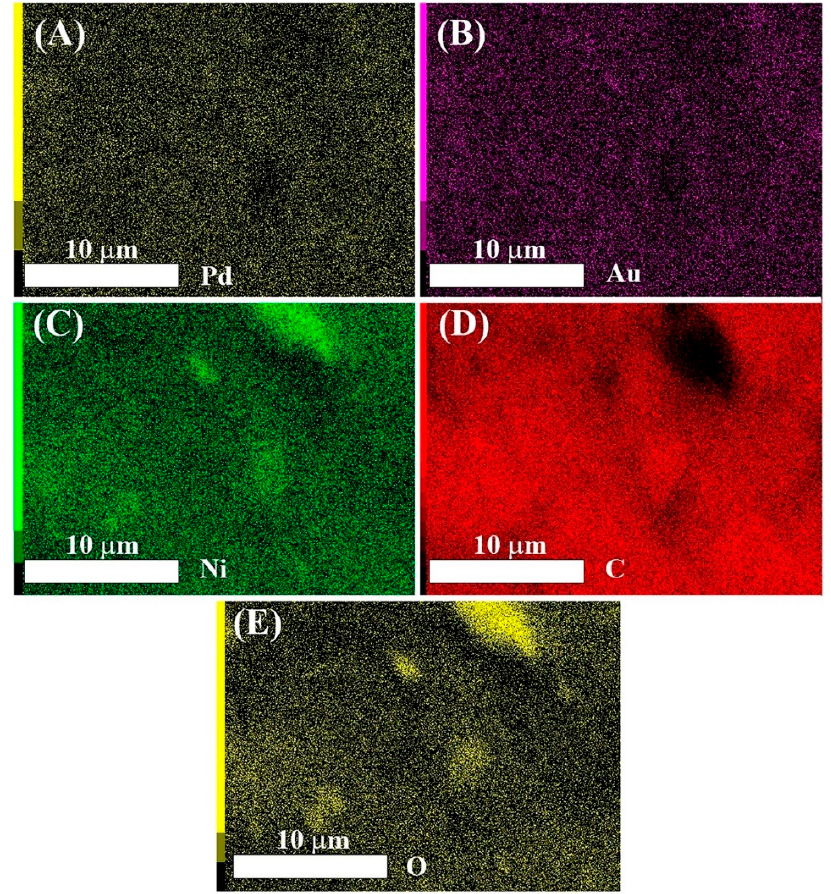
Figure 2. Elemental maps of ( A ) Pd, ( B ) Au, ( C ) Ni, ( D ) C, and ( E ) O obtained by EDX spectroscopy of PdAuNi/C SBEG at 10 kV.